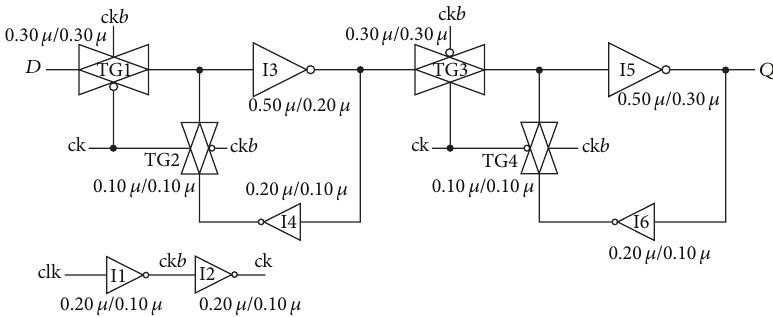
Figure 8: The schematic of ST-TG-FF